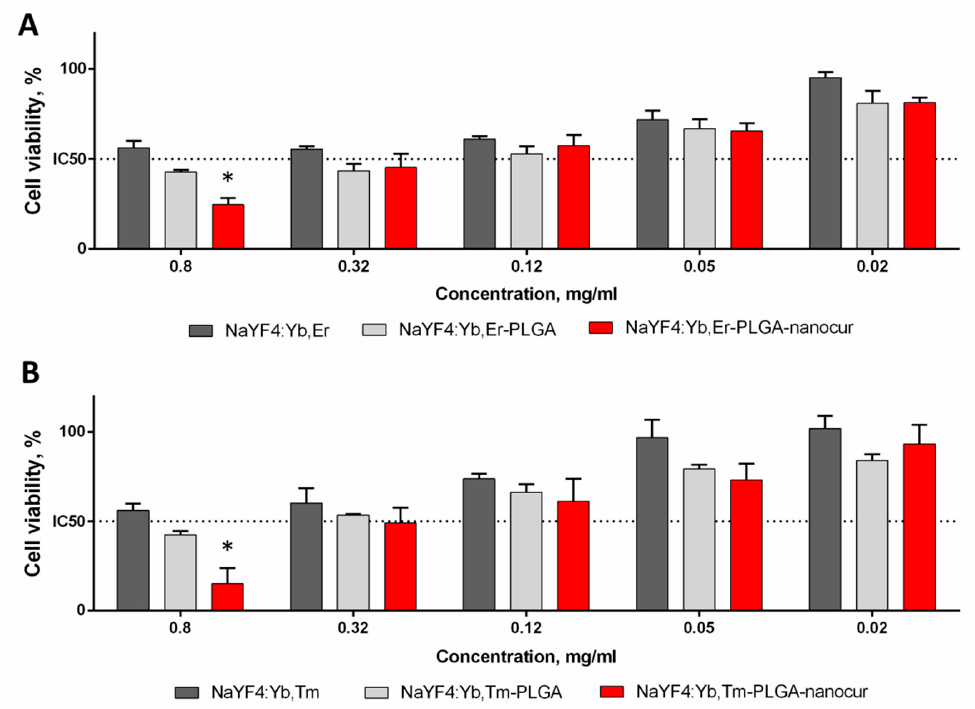
Figure 7. Viability of rat glioma C6 cells after 48 h of incubation with NaYF 4 :Yb,Er-based ( A ) and NaYF 4 :Yb,Tm-based ( B ) nanoparticles. MTT assay, the viability of intact cells was taken as 100%. * p < 0.05 in comparison to blank nanoparticles in Mann–Whitney U test (non-parametric, two-tailed).